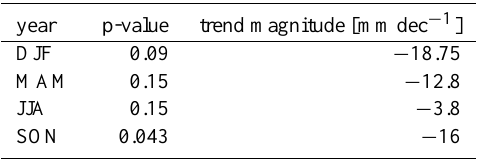
Table 7. Precipitation sums, Santa Rosa station (partly reconstr.)